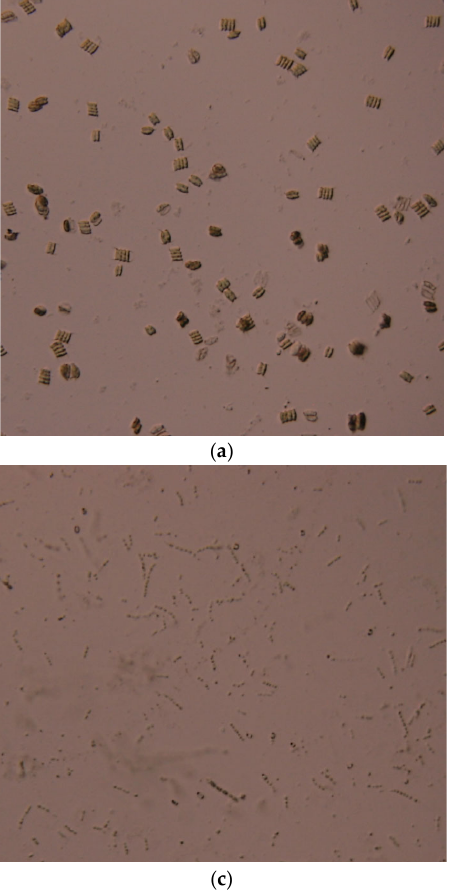
Figure 2. Algae microscope images (( a ) Scenedemus communis , ( b ) Scenedemus sp., ( a , b ) microscopic images of green algae, ( c ) Anabaena fl os ‐ aquae , ( d ) Anabaena sp., ( c , d ) microscopic images of blue- green algae).